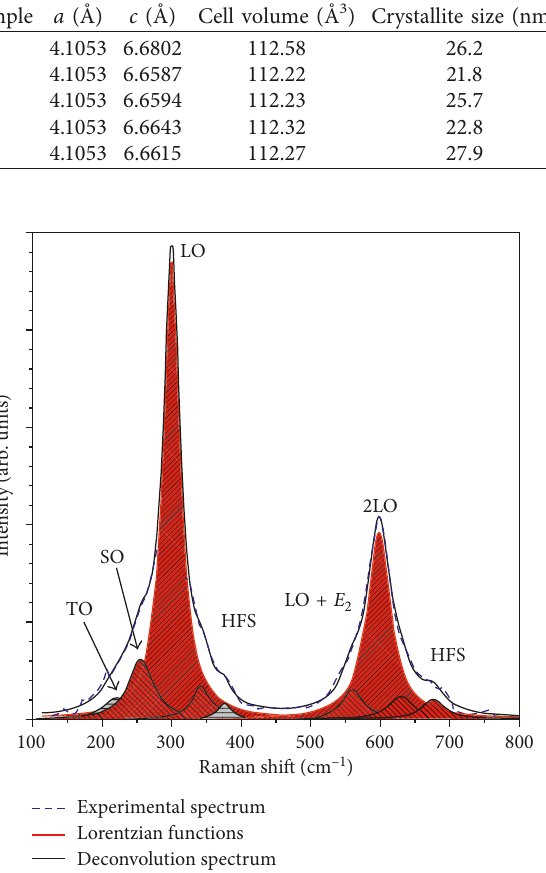
Figure 2: Deconvolution of the Raman spectra for the CdS ref- erence film